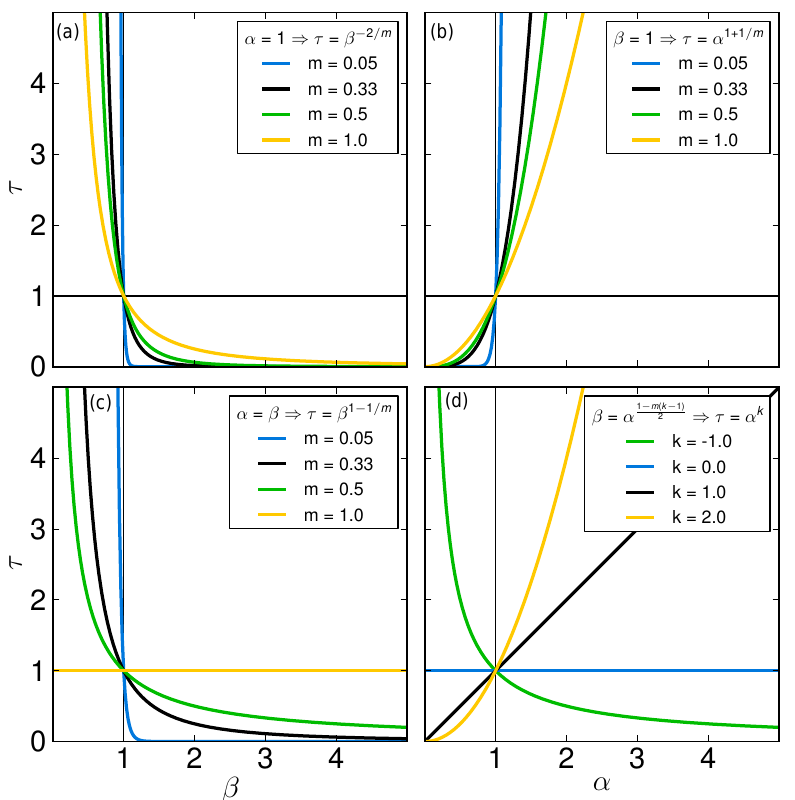
Figure 9. Response-time scaling for hypersurfaces through the α - β - m phase space according to Eq. (24) for (a) α = 1, (b) β = 1, (c) α = β and (d) the constraint that the response-time scaling is independent of m . In each panel the legend gives the scaling law for τ that results from the applied